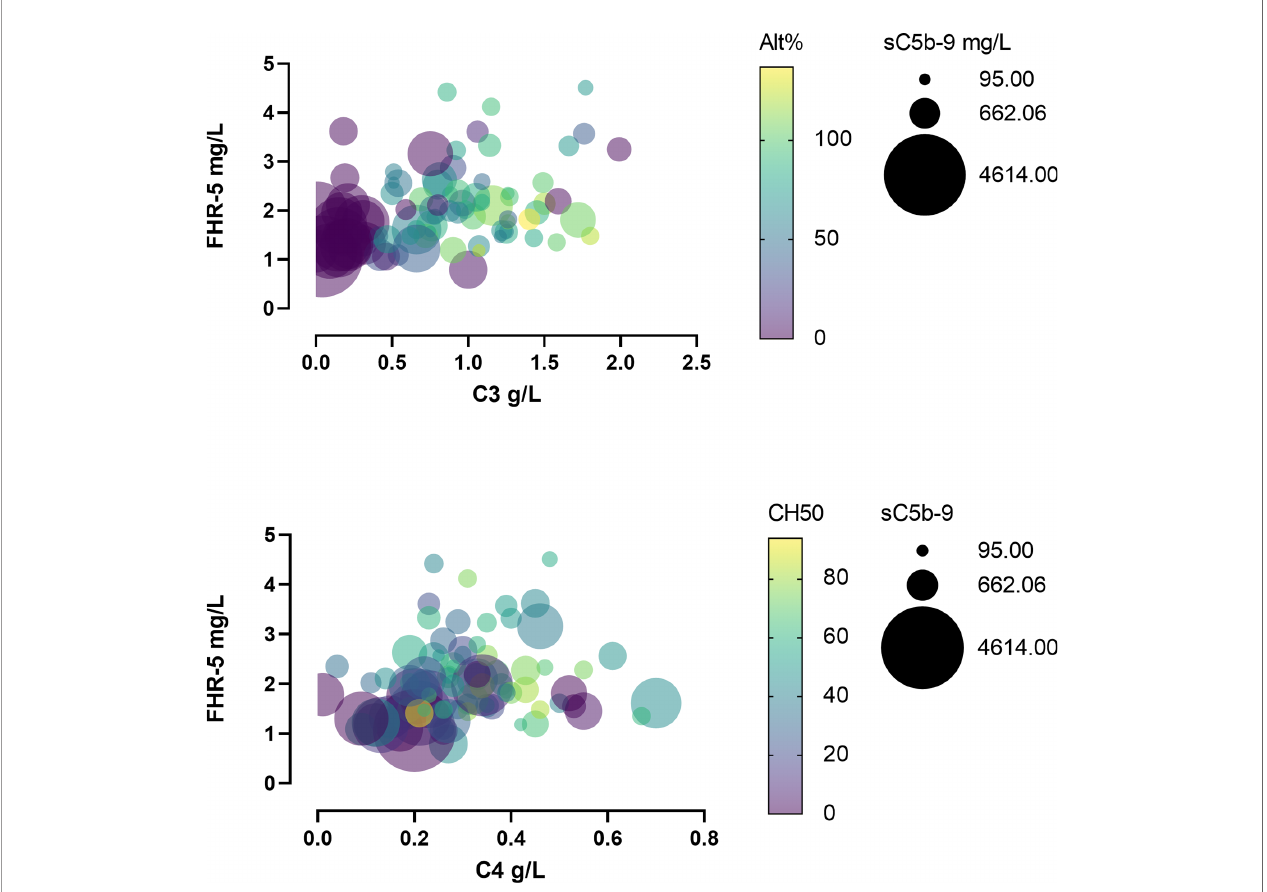
FIGURE 6 | Bubble plot of patients ’ various complement parameters and Factor H-related protein 5 (FHR-5)